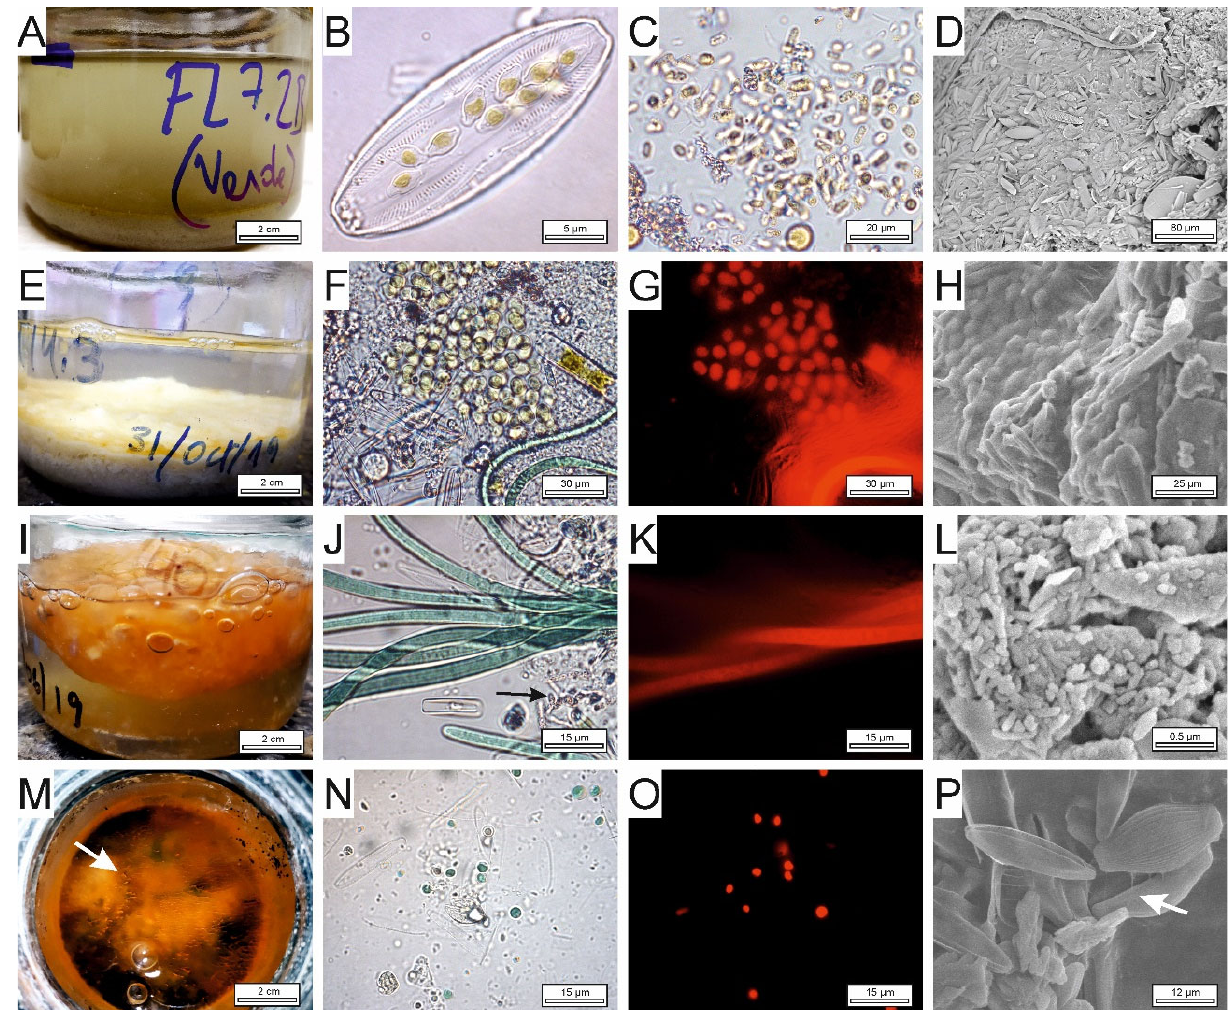
Figure 6 . Set of representative macromorphological and microscopic checkups for Salar de Pajonales (PAJ) and Salar de Gorbea (GOR) microbial mat containers from the beginning of the experiment to >500 days. ( A ) Side view of PAJ ‐ 11 container with a cloudy water column 7 days after starting the experiment. Bright ‐ light microphotographs showing that clouds were due to 4 μ m diatoms in cell division, such as Amphora genus morphotypes, from the PAJ ‐ 16 incubation ( B ) and compatible with Dactylococcopsis genus colonies from the PAJ ‐ 17 incubation ( C ). ( D ) Field emission scanning electron microscope (FE ‐ SEM) photomicrograph of Bacillariophyceae distinctly shaped diatoms (mat crowded predominantly by Amphora , Navicula , and Cocconeis genera) without mineral precipitates in the PAJ ‐ 14 incubation. ( E ) Side view of whitish ‐ to ‐ yellowish PAJ ‐ 16 mat incubated with fine gypsum sub ‐ strate after 30 days. The mat was firmly attached to the substrate, retaining gas bubbles under the gels below a clear water column. ( F ) Spherical, unicellular cyanobacterial cells (10–15 μ m) compati ‐ ble with Chroococcidiopsis genus shown in a bright ‐ light microphotograph in the PAJ ‐ 12 incubation. Two filaments compatible with Oscillatoria genus and algae individuals are also shown. ( G ) The same view as ( F ) under an HBO 100W Hg lamp burner in which photosynthetic pigments were excited, showing autofluorescence of the cells. ( H ) FE ‐ SEM microphotograph displaying a similar view as ( F , G ) of coccoid cells agglutinated in extracellular polymeric substances (EPS) in the PAJ ‐ 12 incubation. ( I ) Side view of orange detached/floating mat of PAJ ‐ 17, packed with gas bubbles, incubated without substrate after 60 days. ( J ) The orange gel contained many micro ‐ organisms. Among the observable micro ‐ organisms, long cyanobacterial filaments, diatoms, and sulfur ‐ oxidiz ‐ ing bacteria (black arrow) with visible intracellular sulfur globules compatible with Oscillatoria, Na ‐ vicula, and Chromatium genera, respectively, stand out, as seen by bright light. ( K ) The same view as